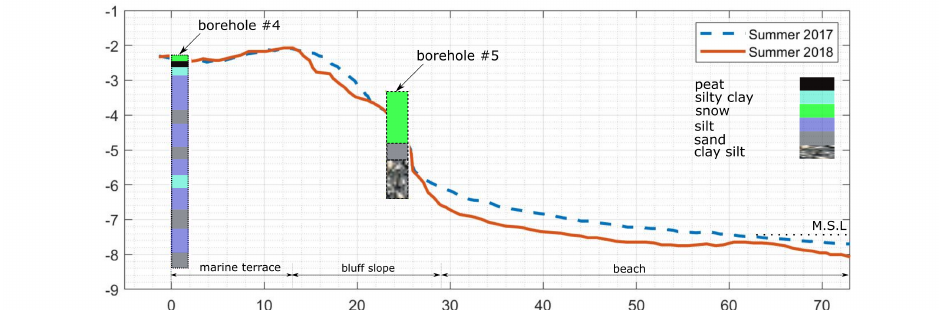
Figure 3. Typical cross section at zone S1 depicting the positions of the boreholes. The boreholes are equipped with thermistor strings to measure the temperature every ten minutes at various levels [25].